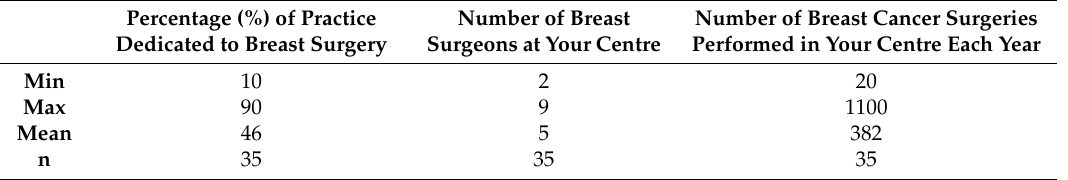
Table 1. Surgical demographic information for survey participants.